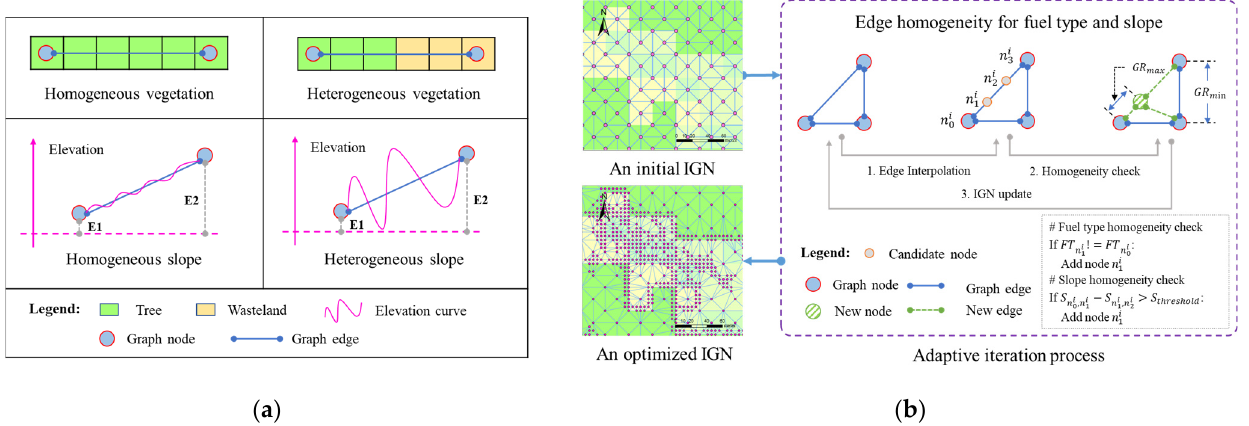
Figure 3. IGN adaptive optimization. ( a ) Homogeneity and heterogeneity in fuel and slope; ( b ) adaptive iteration process for IGN optimization.